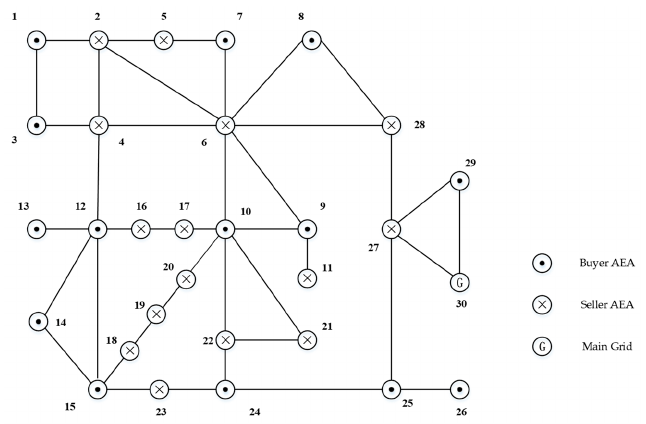
Figure 5. 30-bus test system interconnecting 29 AEAs and integrating to main grid.